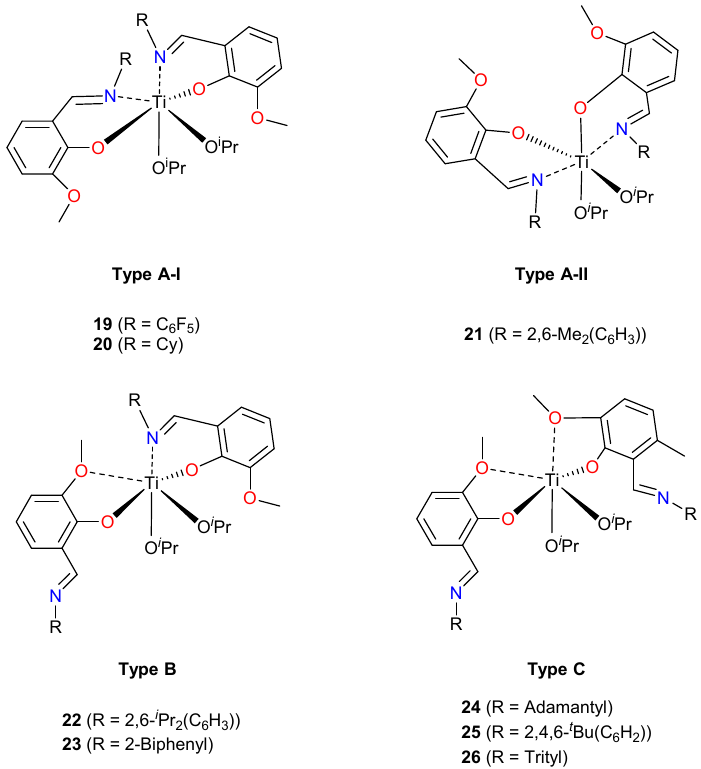
Figure 4. Binding modes of Ti-based complexes 19–26 [43].